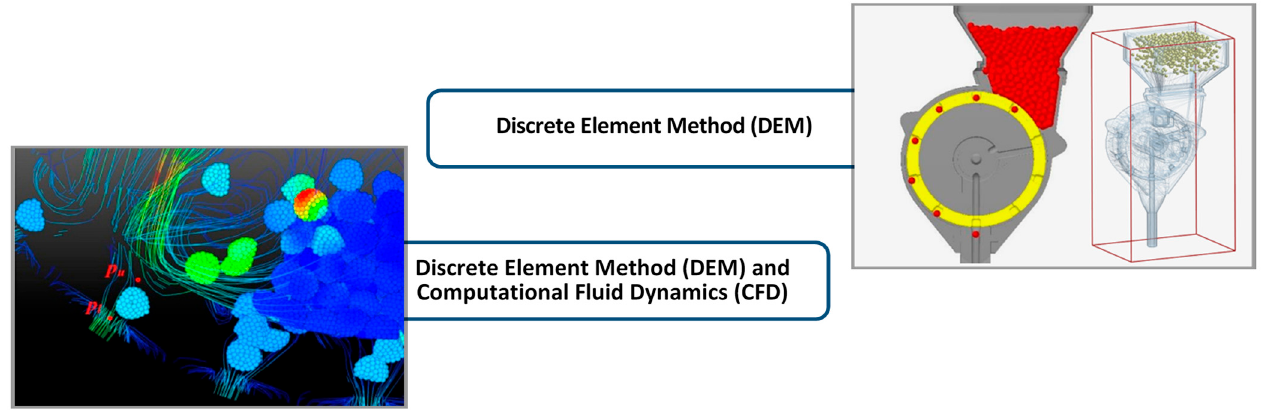
Figure 5. Simulation of the working process of sowing device using numerical